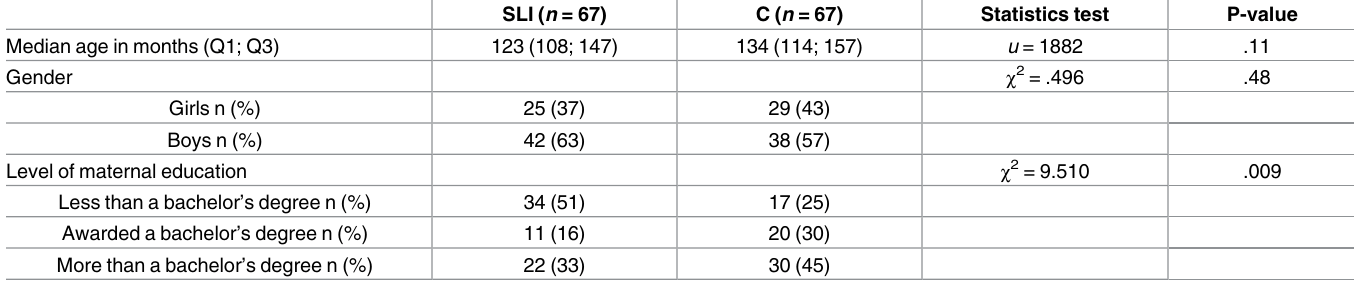
Table 1. Demographic characteristics of the specific language-impairment (SLI) and control (C) groups. Mann-Whitney U -test to comparemedian scores and Chi-square test to compare percentage.